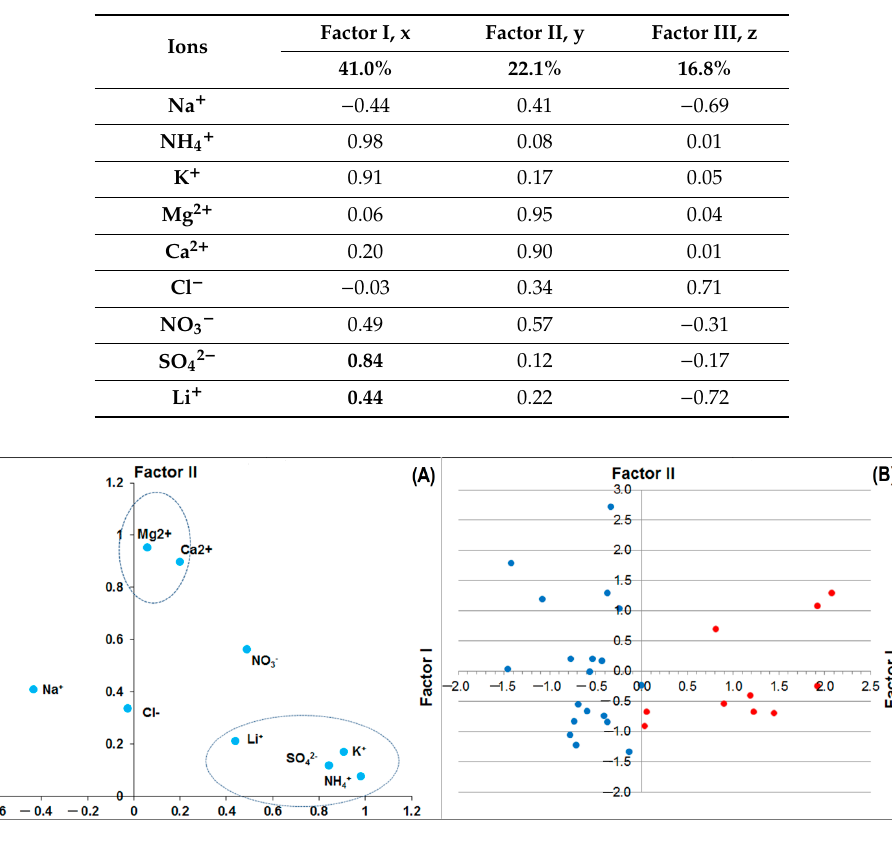
Figure 9. Ion distribution in the space of the first two factors ( A ). The distribution of all collected aerosol samples on the plane of the factors 1 and 2 along the route of RV “Akademik V.A. Koptyug” from 24 July to 4 August 2019 ( B ).